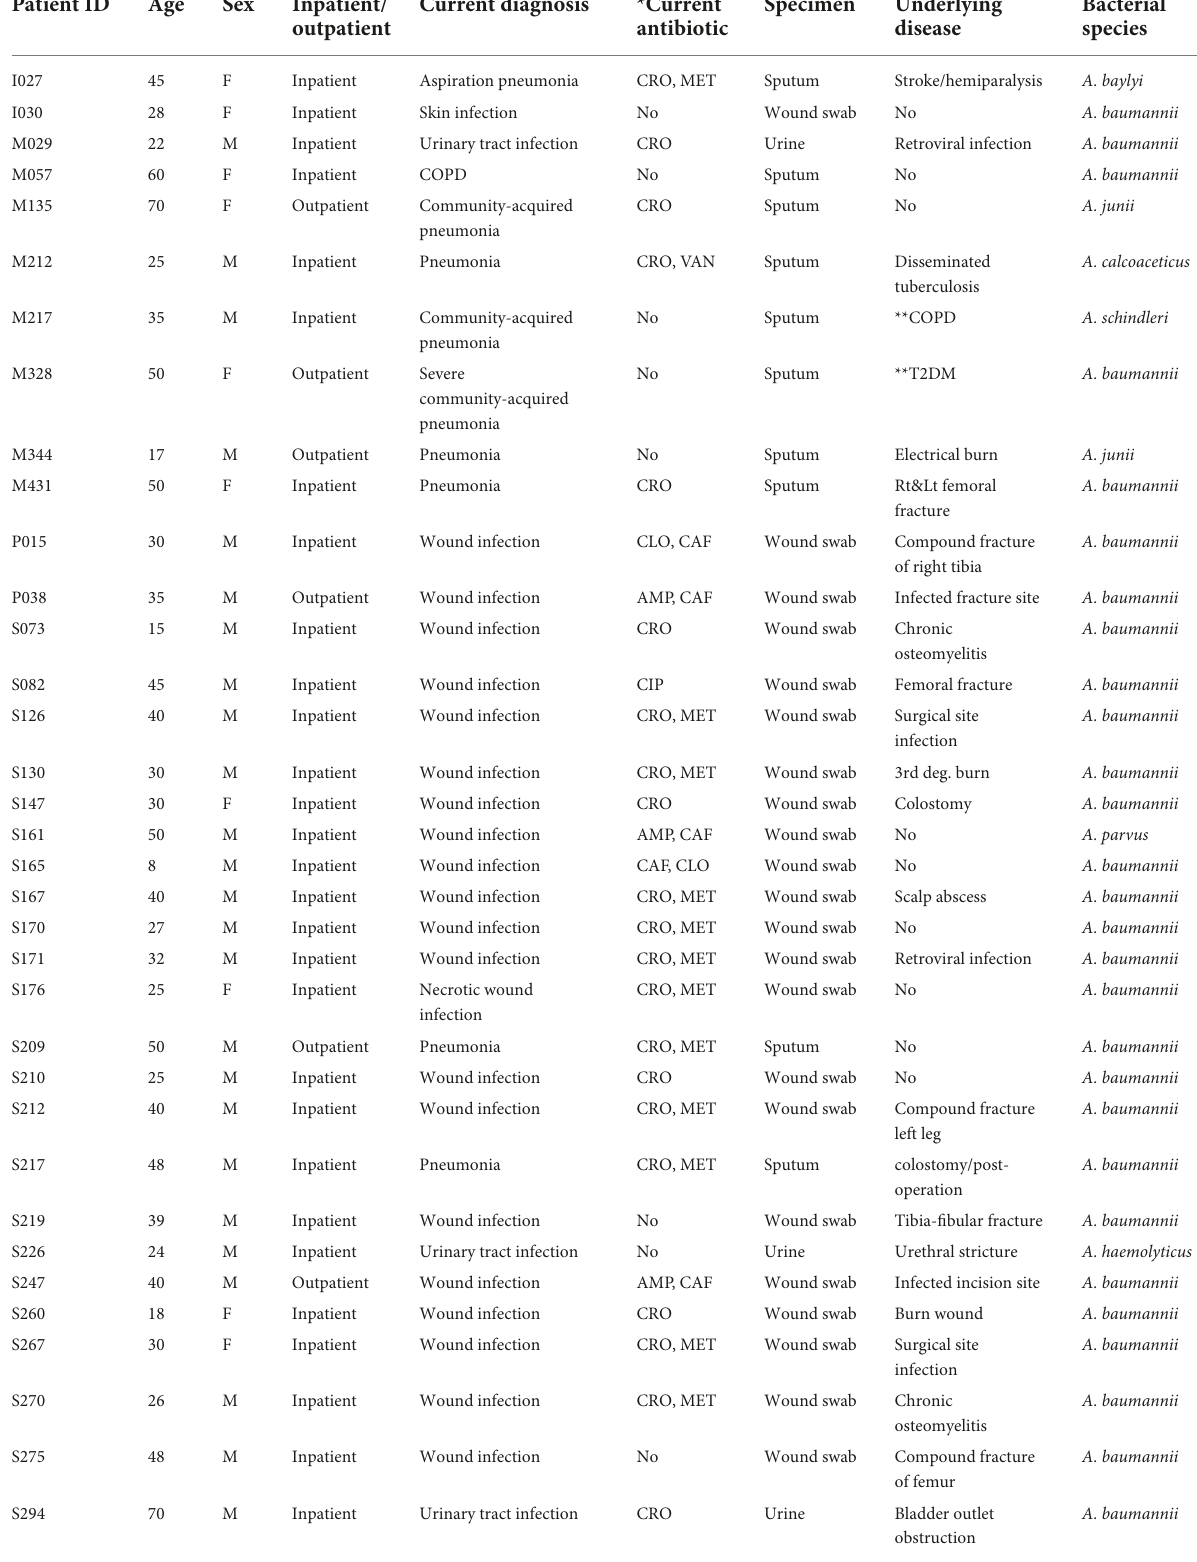
TABLE 1B Socio-demographic and clinical characteristics patients and isolation Acinetobacter species. Patient ID Current diagnosis *Current